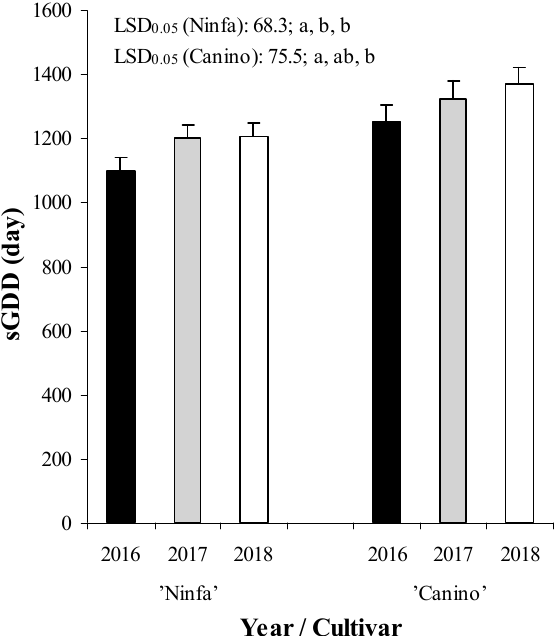
Figure 4. The effect of three years (2016, 2017, 2018) and two cultivars (‘Ninfa’ and ‘Canino’) on sum of growing degree days (sGDD). Data are means of the four irrigation treatments. Standard deviation values are presented by bars on the columns. Differences among years were represented by LSD 0.05 values at P = 0.05, separately for the two cultivars. After each LSD 0.05 value, first, second, and third letters belongs to the years of 2016, 2017, and 2018, respectively. Values within the given cultivar coupled with different letters are significantly different among the years at P = 0.05 according to LSD t -tests. Table 4. Analyses of variance for the effects of year, deficit irrigation treatment and cultivar on bud measures of tree physiological properties (total number of buds—TNB, number of flower buds—NFB, number of vegetative buds—NVB, starting date of flowering—SDF, number of opened flower buds—NOFB and flower bud abscission (%)—FBA) in a commercial apricot orchard at Wadi El Natrun, Northern Egypt over 2016–2018 on two apricot cultivars ‘Ninfa’ and ‘Canino’.